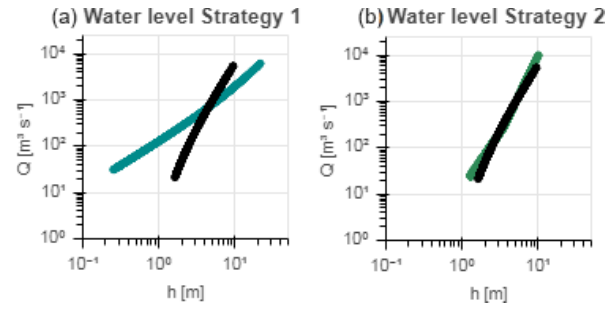
Figure 11. Discharge–water-level graphs for the recorded (black) and modelled discharge and stream levels with the optimal model performance ( E NS ) using the Strickler–Manning equation for the discharge–stream-level conversion with cross-section information (a) extracted from Google Earth (Water level Strategy 1) or (b) ob- tained from a detailed field survey with an ADCP (Water level Strat- egy